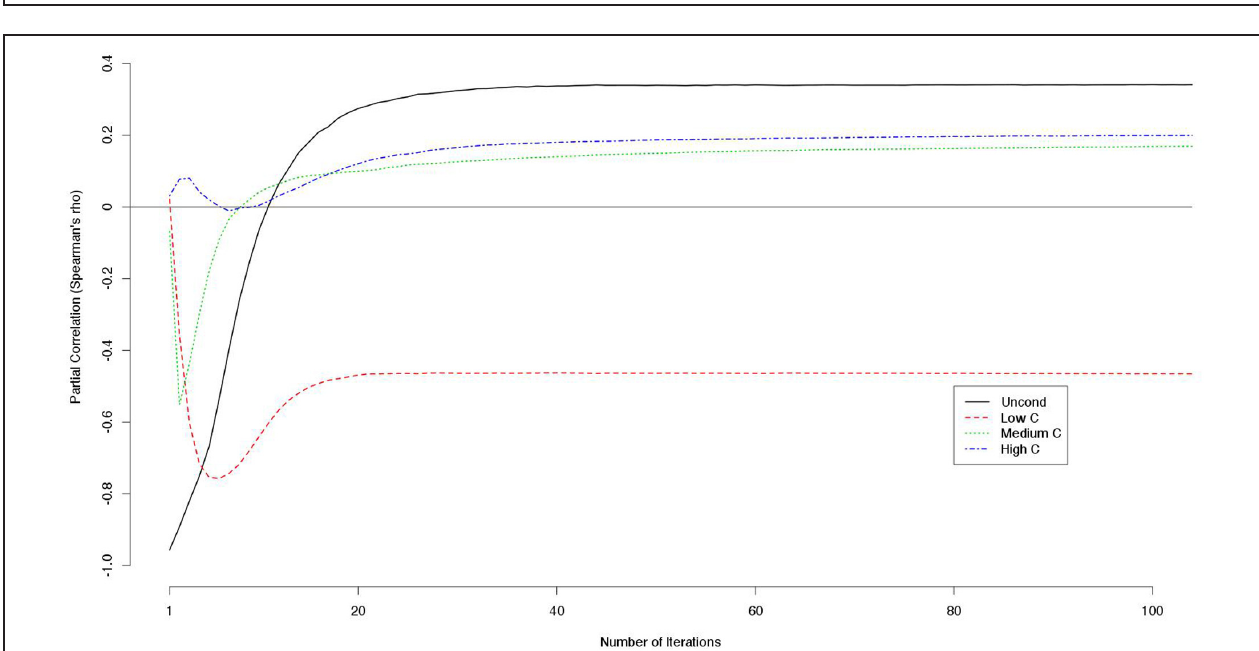
FIGURE 2 | Partial correlations between decision scores and outcomes controlling for the other decision scores (e.g., partial correlations between UC2 score and the outcome controlling for the LC2, MC2, and HC2 scores are indicated).